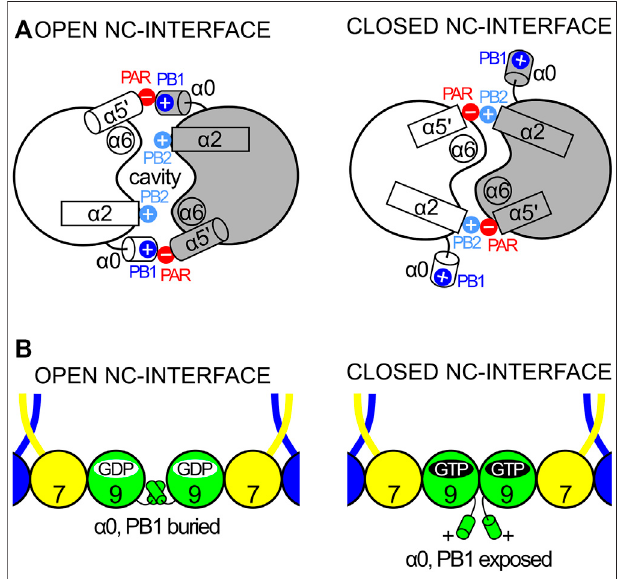
FIGURE 13 | The dual role of the PAR, the exposure of PB1 and the concertina movement at the NC-interface. (A) When the interface is open, the PAR interacts with PB1 (left) but when closed with PB2 (right). (B) The closure oftheinterfaceresultsinexposing α 0anditsassociatedPB1,releasingit fromitsburied(inactive)stateintheNC-interfaceandenablingitformembrane